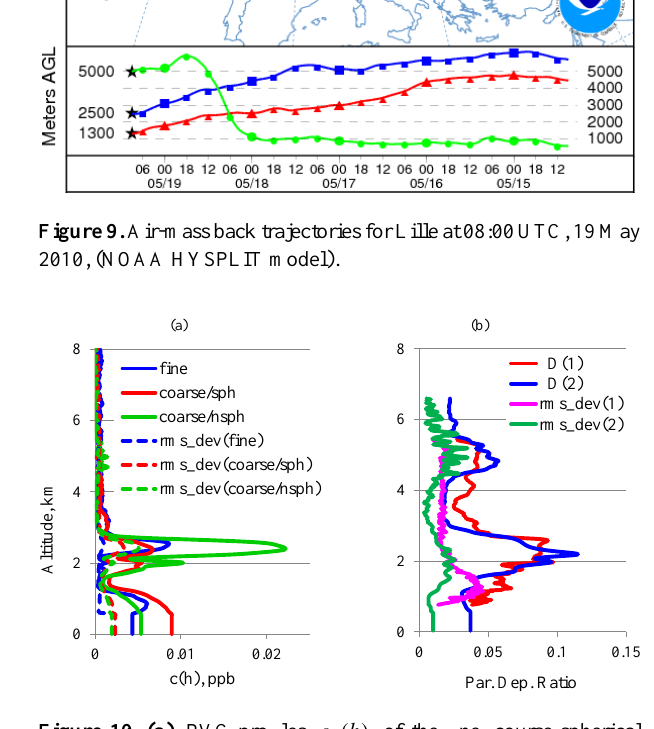
Figure 10. (a) , PVC profiles, c k (h) , of the fine, course-spherical (coarse/sph) and coarse-nonspherical (coarse/nsph) aerosol modes, and their rms-deviations (rms_dev(fine), rms_dev(coarse/sph), and rms_dev(coarse/nsph)); (b) , particle depolarization ratio, D(1) and (2), and their rms-deviations, rms_dev(1) and rms_dev(2). Profiles were retrieved from the data measured in Lille, 19 May 2010, 09:17–09:58UTC. Profiles D(1) and rms_dev(1) are the results of the direct calculation of depolarization ratio and their rms- deviations from lidar measurements, as well as D(2) and rms_ev(2) were calculated from retrieved aerosol mode concentrations, c k (h)